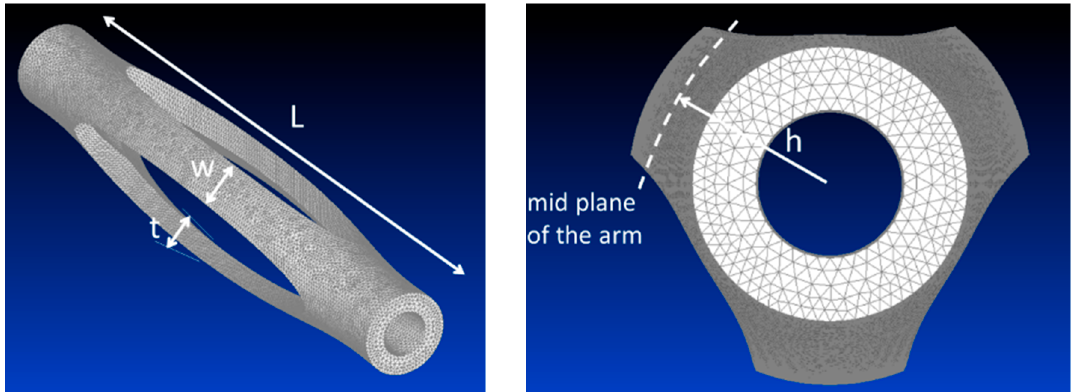
Figure 7. Finite element model of the cell body: global view and main dimensions ( left ); mid-span cross-section ( right ) [30]. Table 1. Main features of the cell FE